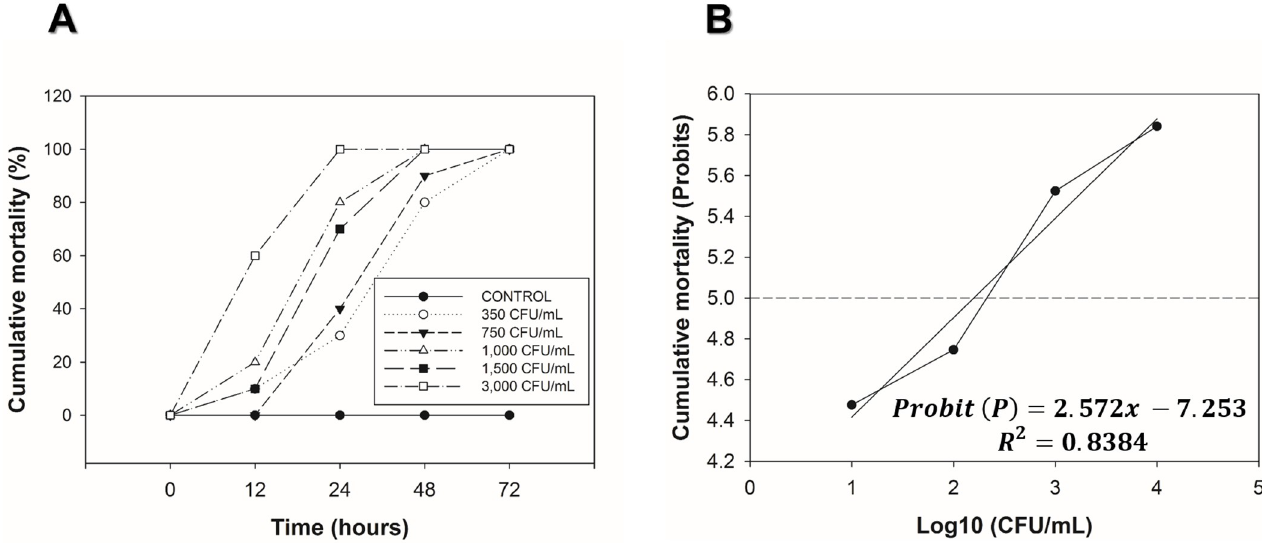
Fig 1. LC 50 doses calculation at different time points in Litopenaeus vannamei after Vibrio parahaemolyticus IPNGS16 infection. (A) LC 50 standardization curve using a range of bacterial concentrations (from 350 to 3,000 CFU/mL), X-axis shows different time points where shrimp mortality was measured, Y- axis represents the percentage of cumulative shrimp mortality (n = 30). (B) The graph represents a Probit model, in the X- axis are the bacteria concentrations values [CFU/mL], in the Y- axis the Probit values for cumulative mortality, the dotted line represents the value of intersection to calculate the LC 50 . The LC 50 value was determinate at [660.95